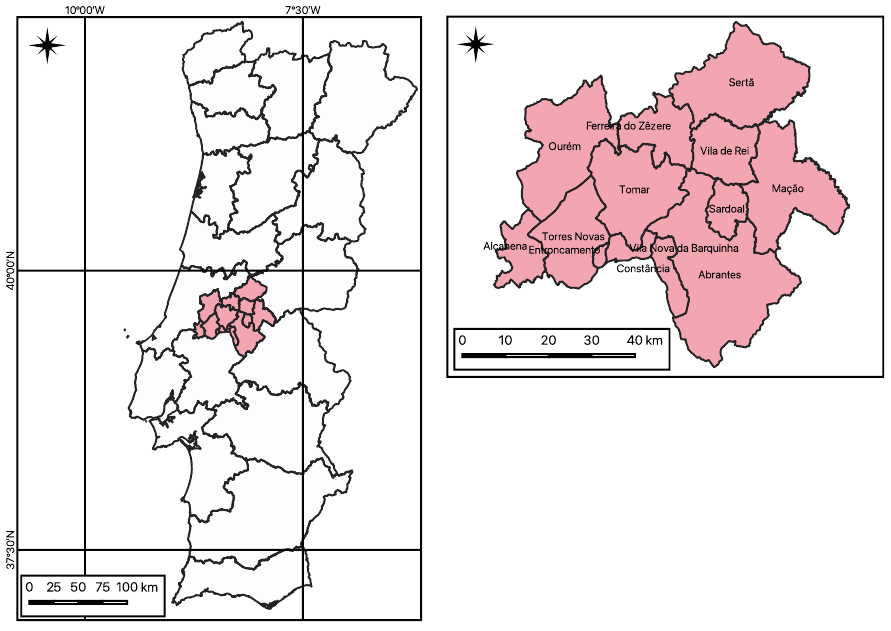
Figure 4. Location of the Médio Tejo region.